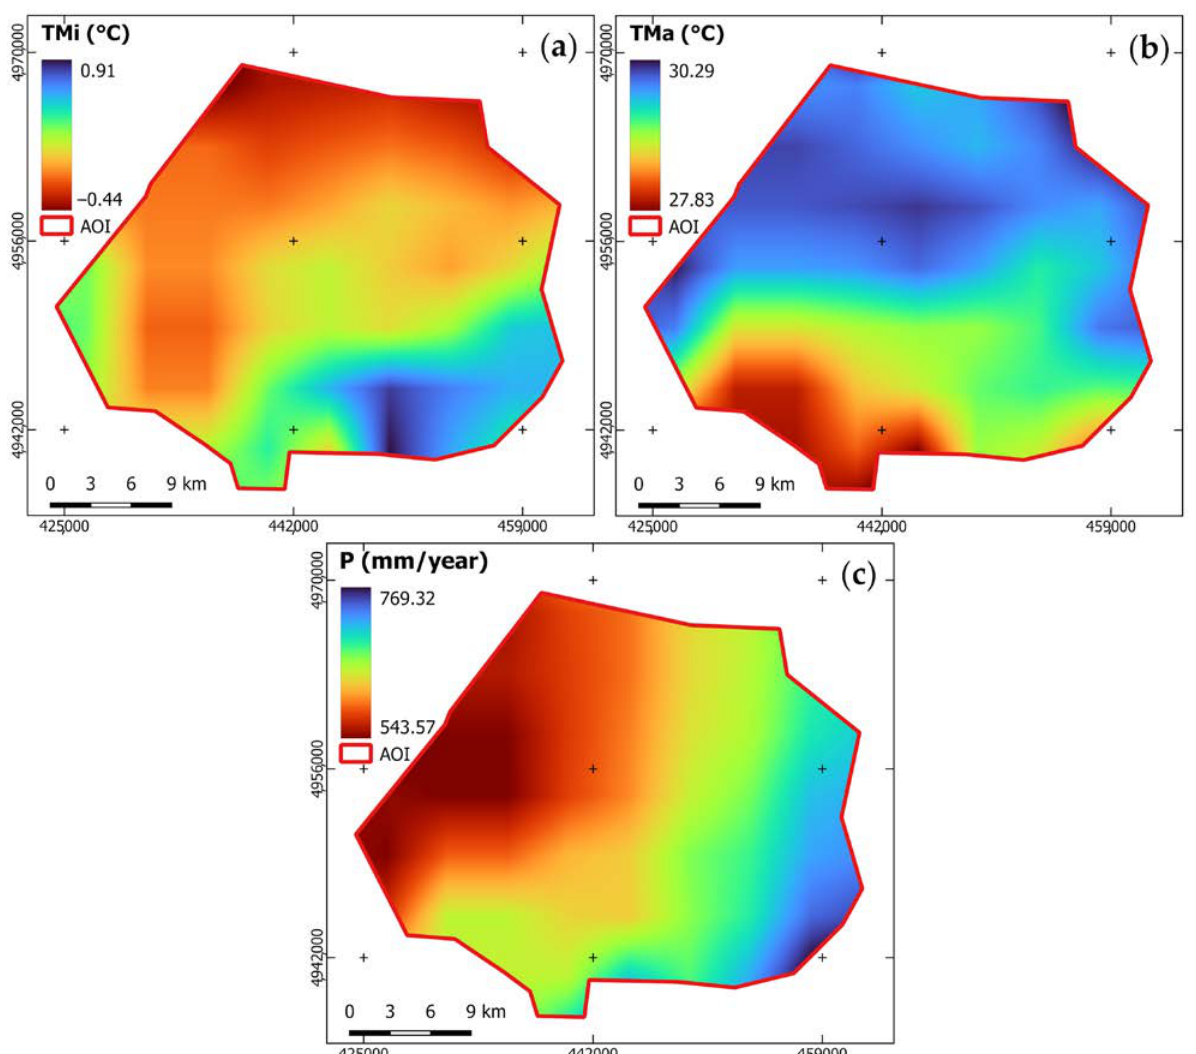
Figure 6. Raster layers mapping climatic features in the study area: ( a ) average yearly minimum temperature ( TMi — °C); ( b ) average yearly maximum temperature ( TMa — °C); and ( c ) average yearly cumulated precipitation ( P — mm/year). (EPSG: 32,632, WGS 84/UTM zone 32N). As far as terrain morphology (topography) is concerned, the native DTM ( H ), slope ( SL ), and aspect layers ( AS ) were considered. In AOI, H ranges between about 103 and 734.15 m a.s.l. , SL between 0° and 76°, and AS between 0 rad and 6.28 rad. If focusing on vineyards only, (i) H varies from 125 m a.s.l. to its maximum; (ii) SL ranges between 0° and 28°; and (iii) AS is always between 0 rad and 6.28 rad. Concerning topography, following the transformation of AS in AS′ (Equation (1)), the results are shown in Figure 7. The pedological, climatic, and morphological raster layers were standardized, thus generating 10 new standardized raster maps (namely, SA ST , SI ST , CL ST , pH ST , TMi ST , TMa ST , P ST , H ST , SL ST , and AS (cid:48) ST